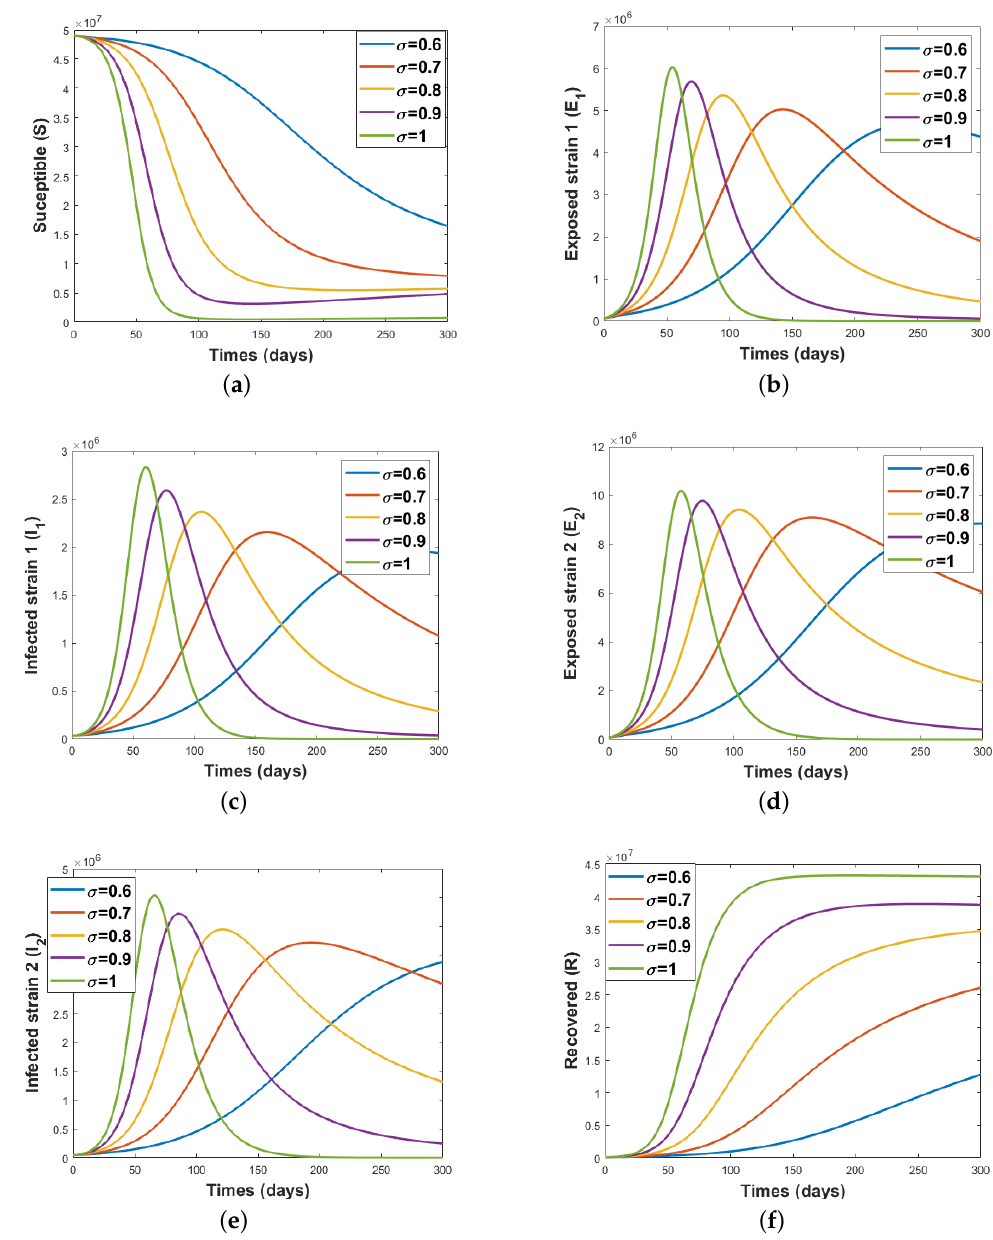
Figure 3. Numerical simulation for the fractional model (9) when σ = 1,0.9,0.8,0.7 and 0.6, where ( a ) Susceptible individuals, ( b ) Exposed individuals to strain 1, ( c ) Infected individuals to strain 1, ( d ) Exposed individuals to strain 2, ( e ) Infected individuals to strain 2, and ( f ) Recovered